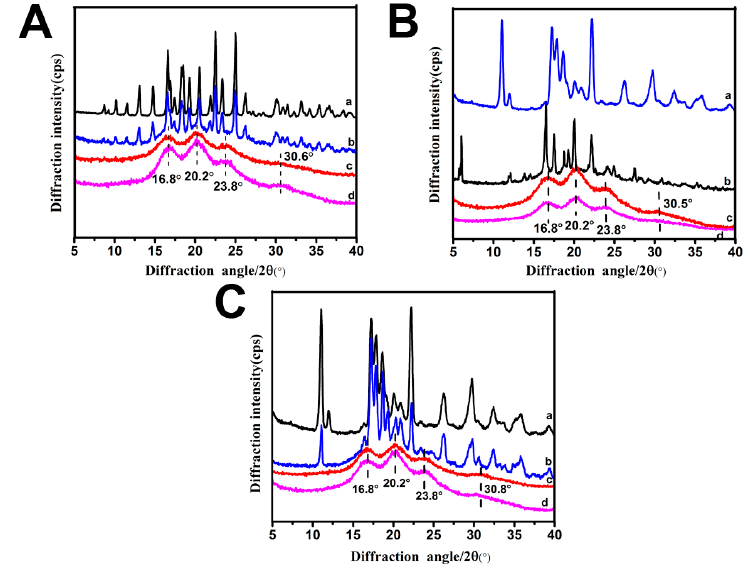
Figure 5. The structure of Ap F nanoparticles. ( A ) XRD of DOX- Ap F nanoparticles ( a , DOX; b , DOX mixture with Ap F nanoparticles; c , DOX- Ap F nanoparticles; d , Ap F nanoparticles); ( B ) XRD